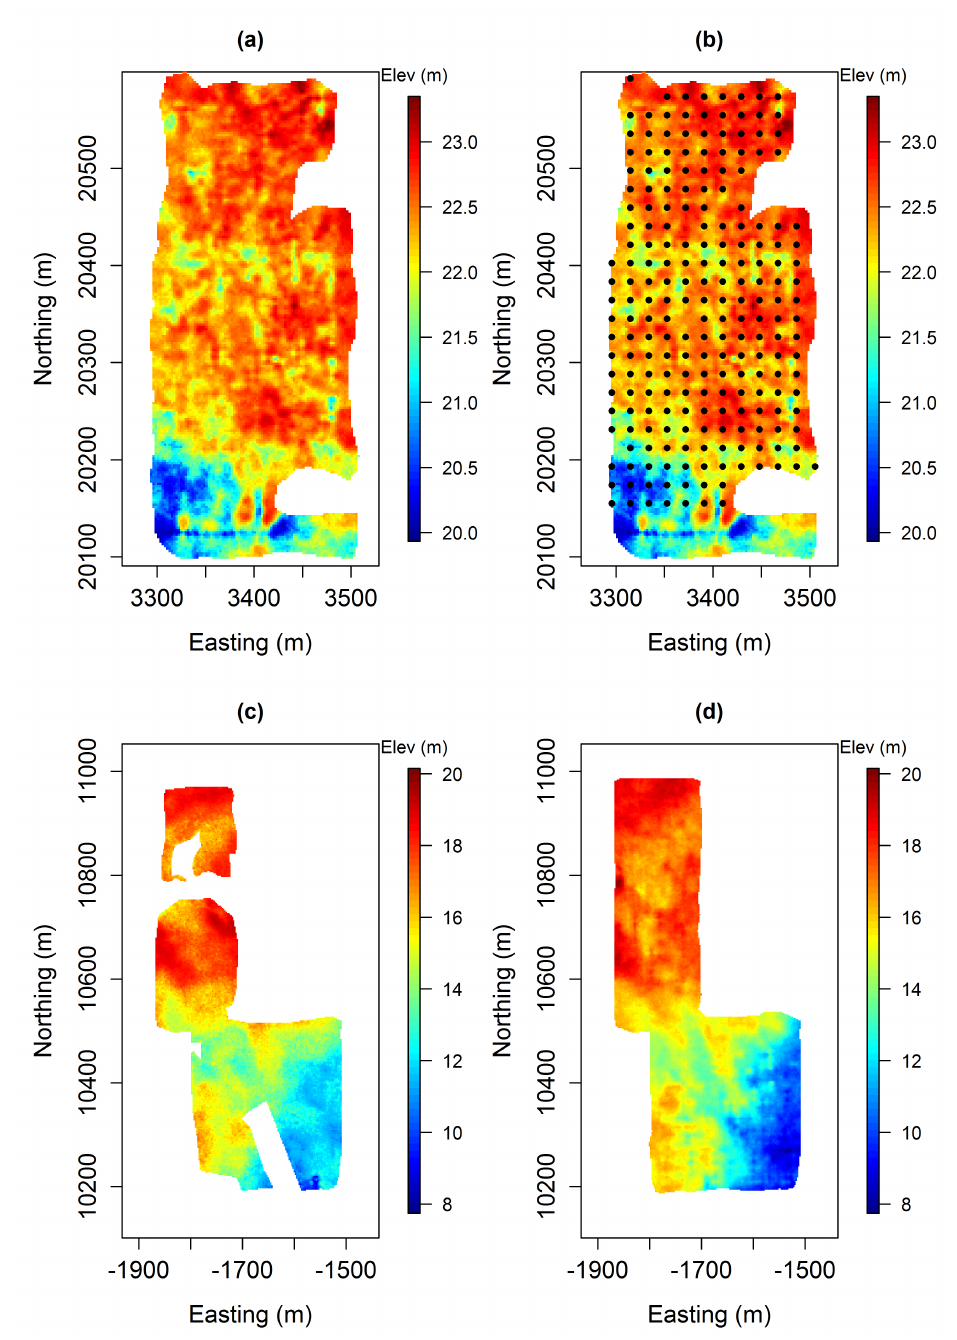
Figure 1. Simulation and the TI variables: ( a ) GPR variable used as the secondary simulation variable; ( b ) borehole data used to condition the simulations (primary variable-black dots overlying the GPR survey); ( c ) floor survey of a previously extracted mine area (primary TI variable) and ( d ) GPR data of the previously mined area collected prior to the extraction (Secondary TI